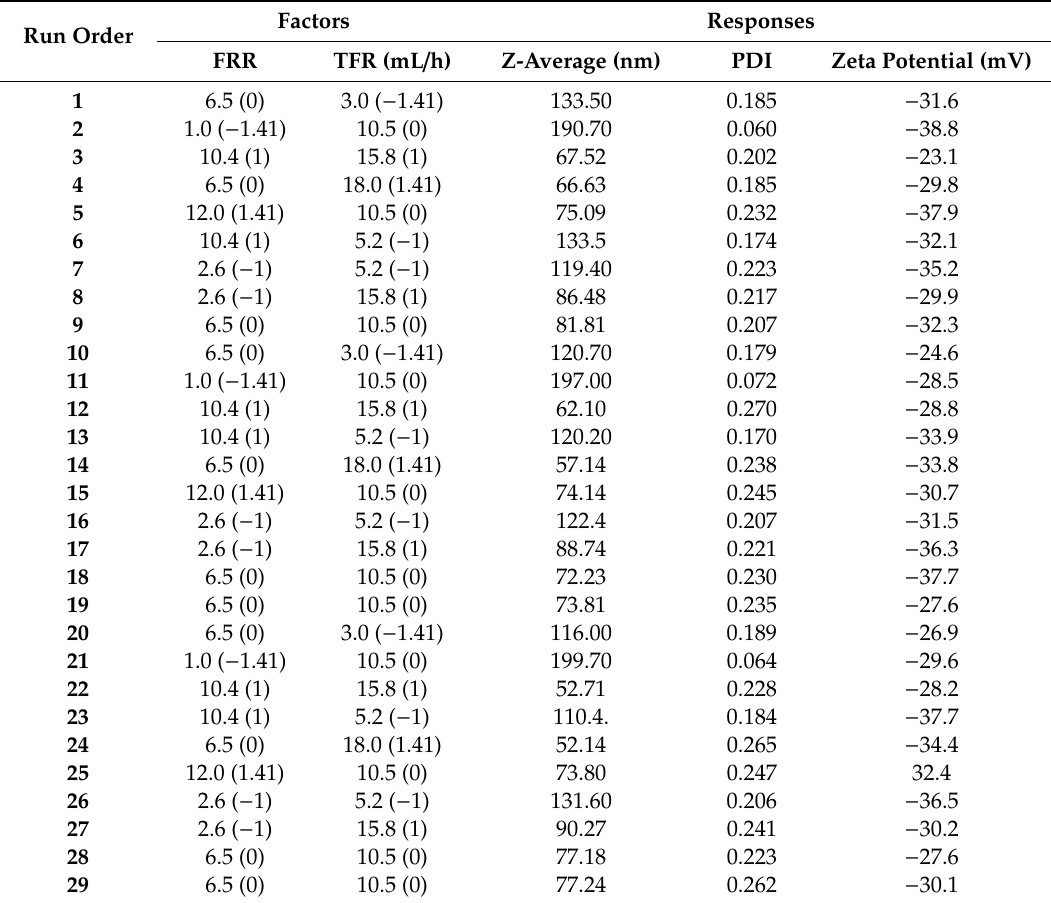
Table 2. CCCR design results for the 29 runs. In parenthesis, the coded values are given. The factors are Flow Rate Ratio (FRR) and Total Flow Rate (TFR). The coded values are in parenthesis, as shown in Figure 2. The responses are the size (Z-average), Polydispersity Index (PDI), and zeta potential. Run